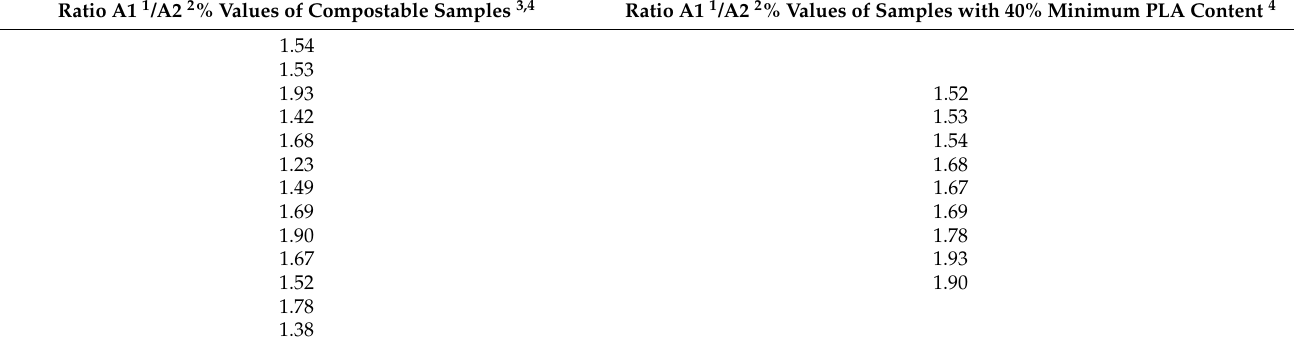
Table 3. Numerical data and statistical descriptive parameters which were necessary for performing the Student t -tests. Ratio A1 1 /A2 2 % Values of Compostable Samples